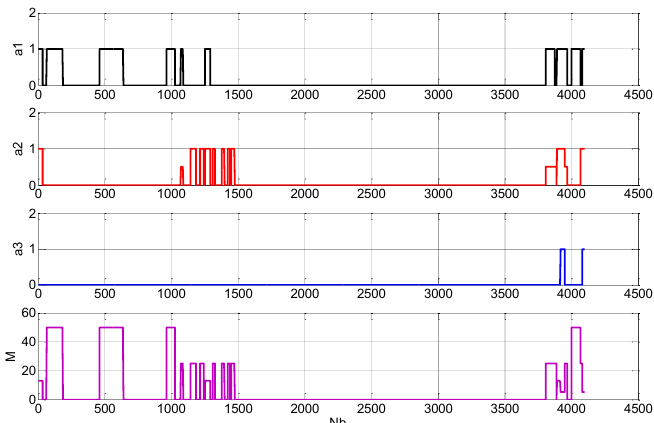
Figure 9. Schematic diagram of three pulses emitted by each fire group of the